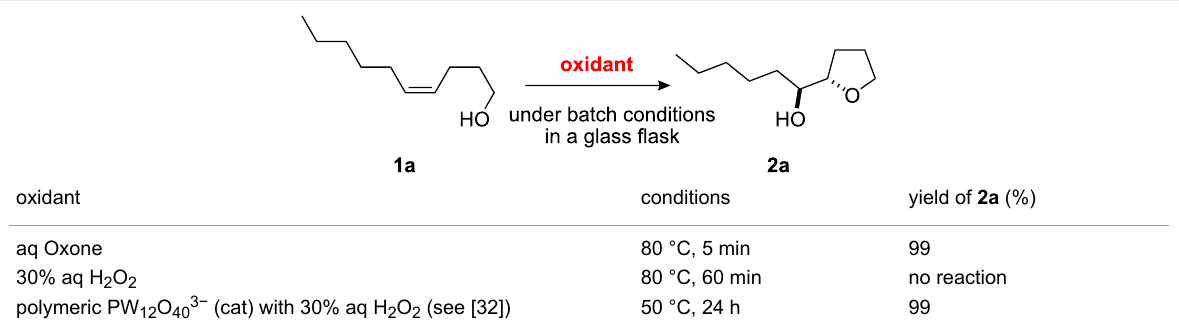
turn our attention to developing an oxidative cyclization